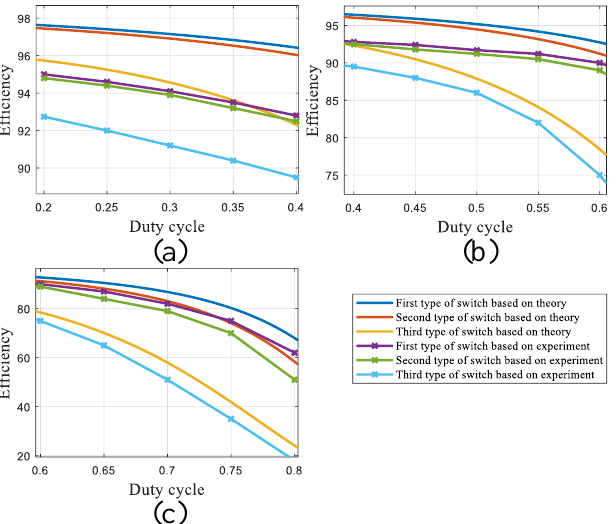
Figure 21. The efficiency comparison based on the theory and experimental results of the three various switch types while the duty cycle changes from ( a ) 0 to 33%, ( b ) 33% to 66%, and ( c ) 66% to 100%.